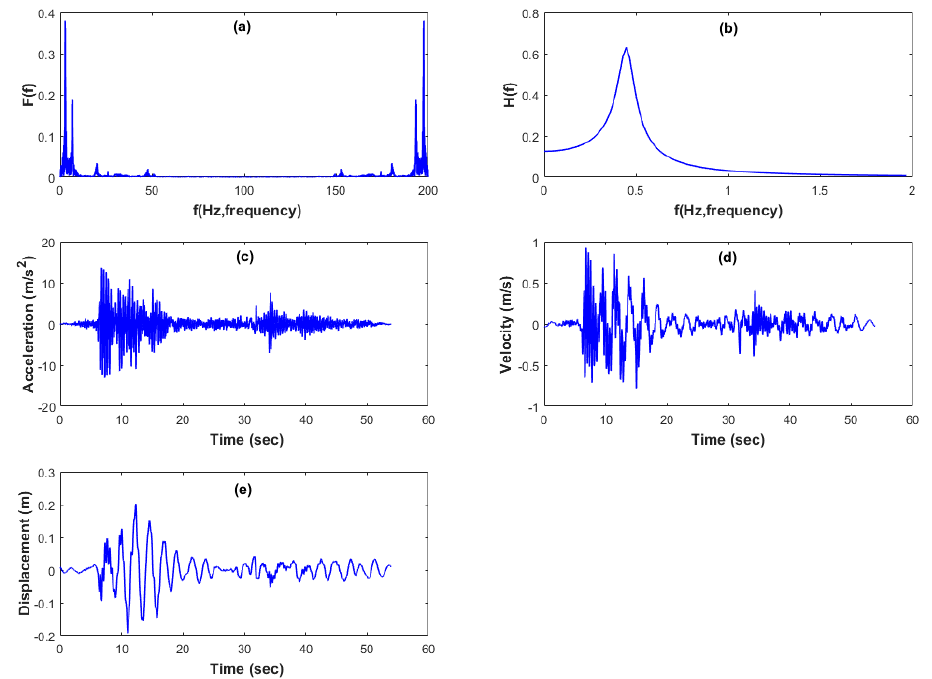
( a ) discrete Fourier Transform of the applied load; ( b ) transfer function; ( c ) acceleration; ( d ) velocity; Figure 12. Analysis process for the 10th-story acceleration in the Manjil earthquake using Method 1: